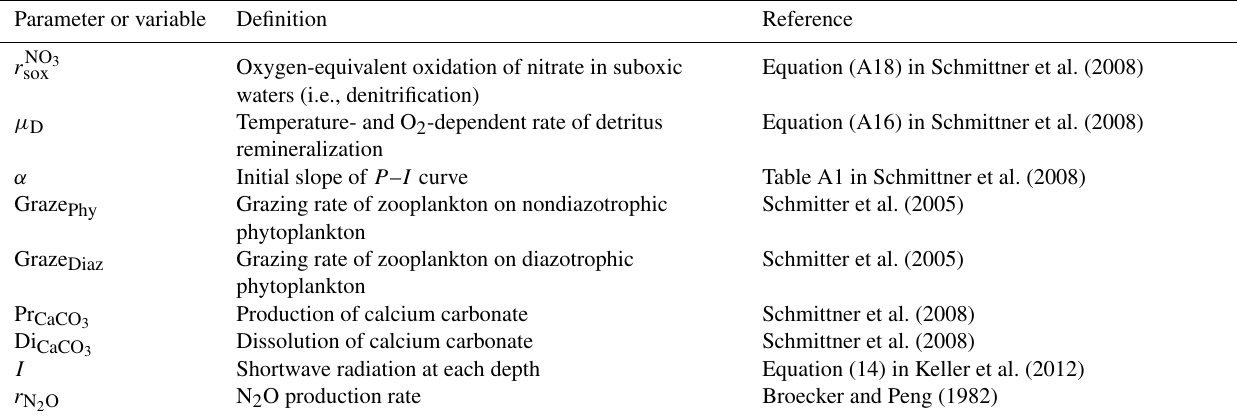
Table B2. Definitions of parameters and variables not mentioned specifically in the text.